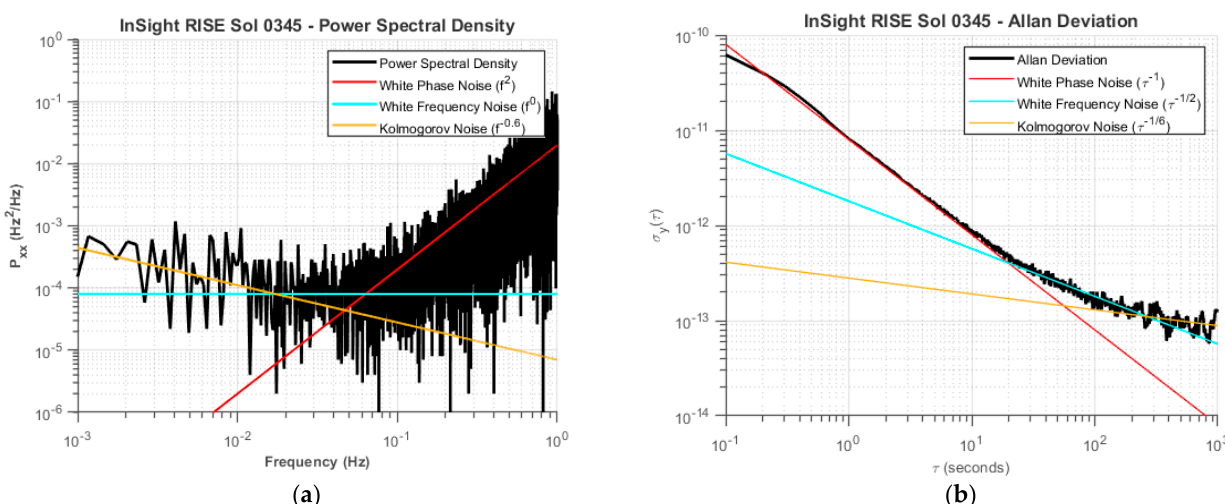
Figure 3. ( a ) Power spectral density of 0.1 s residual frequency for the Sol 345 pass, showing the white phase noise dominance. ( b ) Allan deviation (fractional frequency stability) of the Sol 345 pass. Fits of the three primary noise component models (white phase noise, white frequency noise, and Kolmogorov noise) are shown.